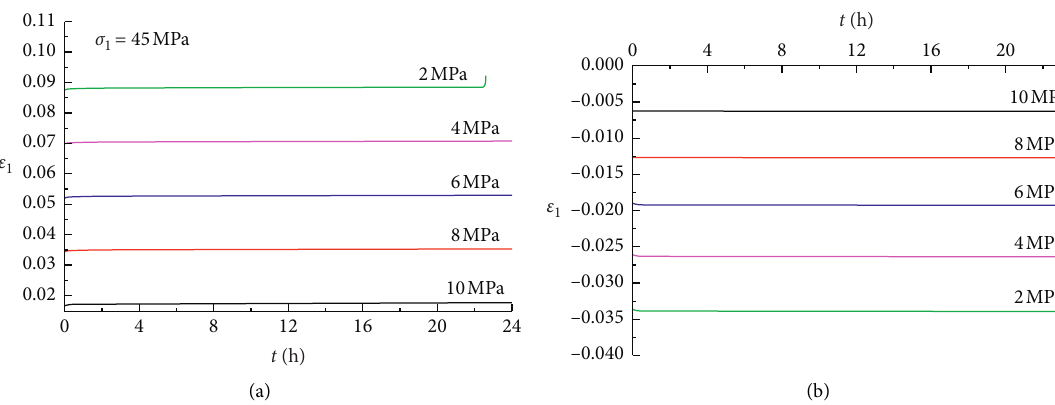
� 45MPa). (b) A30 ( σ � 40MPa). 1 1